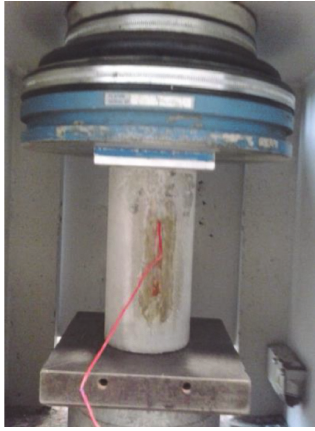
Figure 2: Compression stress-strain test for